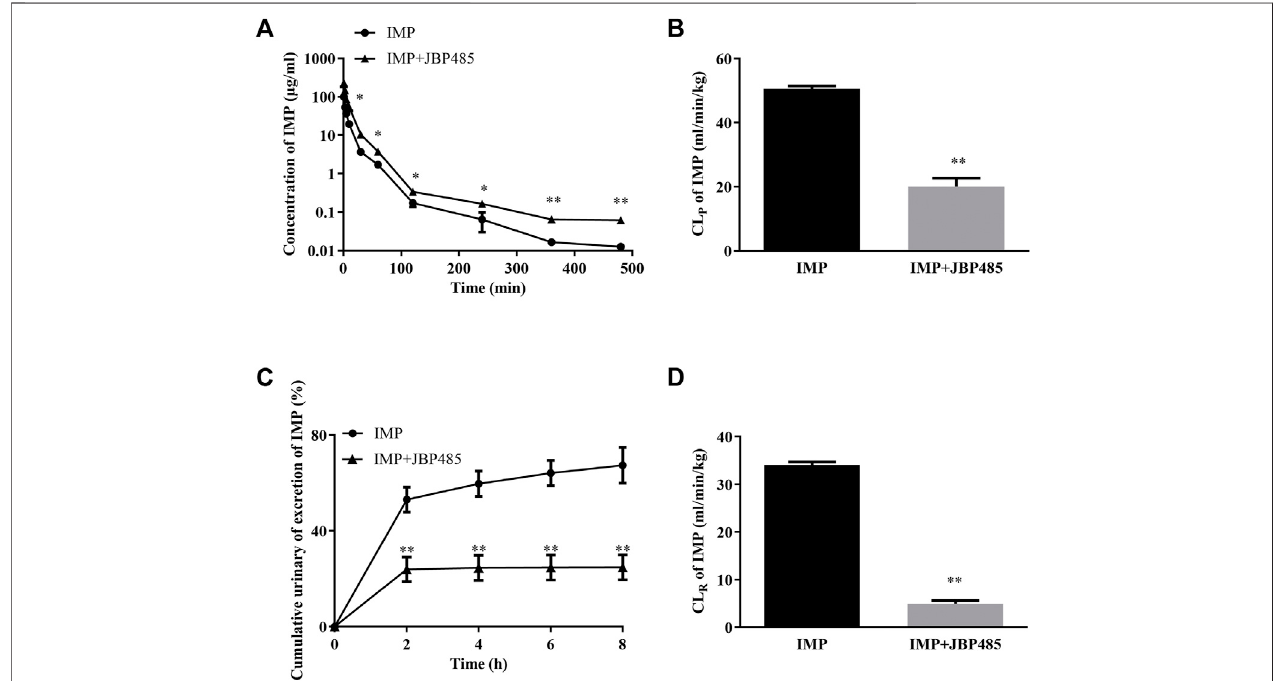
FIGURE 3 | Effect of JBP485 on the pharmacokinetics of IMP in rats. Mean plasma concentration-time curves (A) , plasma clearance (CL P ) (B) , cumulative urine excretion curves (C) , and renal clearances (CL R ) (D) of IMP after intravenous administration ofIMP and JBP485 in rats. Data are expressed as the mean ± SD. * p < 0.05 and ** p < 0.01 compared with control ( n =